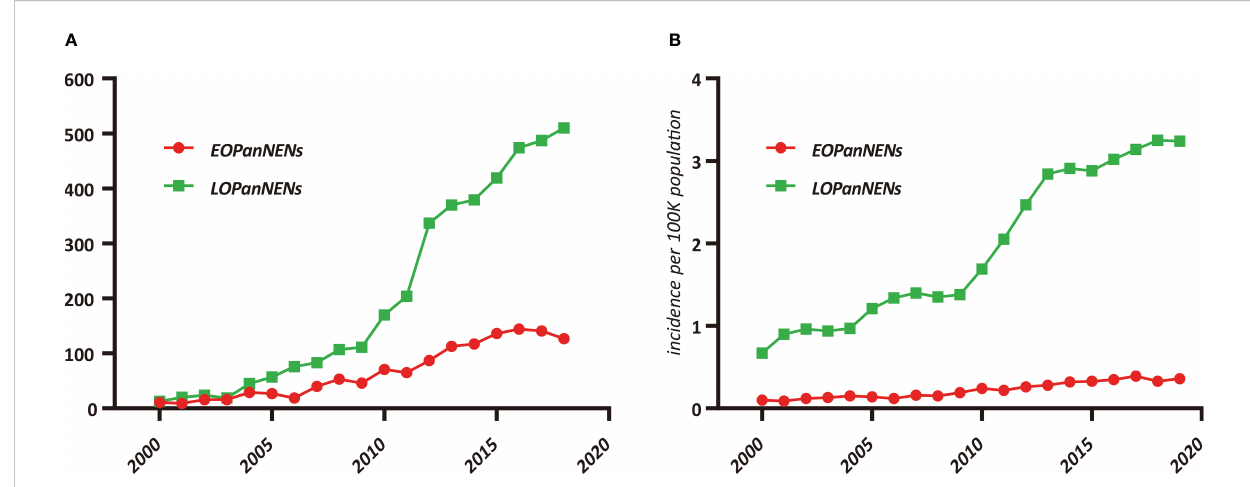
FIGURE 1 Trends in pancreatic neuroendocrine neoplasms (PanNENs) Incidence (2000 – 2018) in the United States, according to age. (A) Incidence of EOPanNENs and LOPanNENs cases per year. (B) Age-adjusted incidence of EOPanNENs and LOPanNENs in the overall